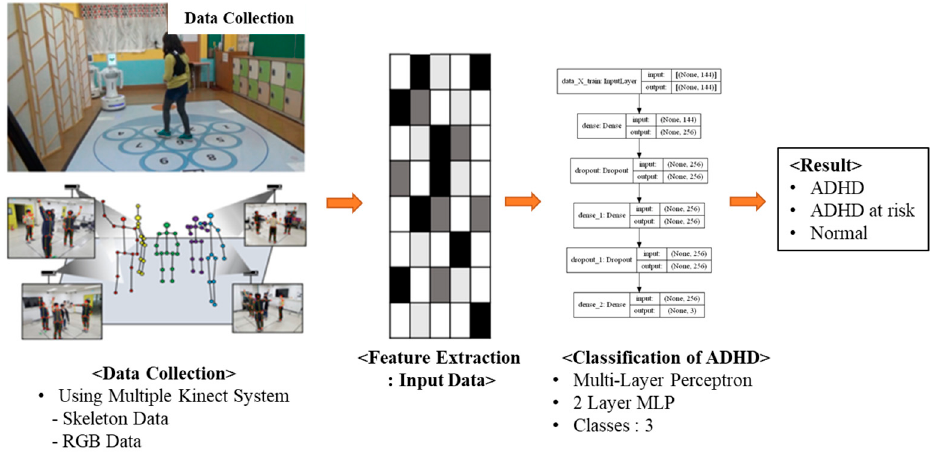
Figure 1. A schematic of this